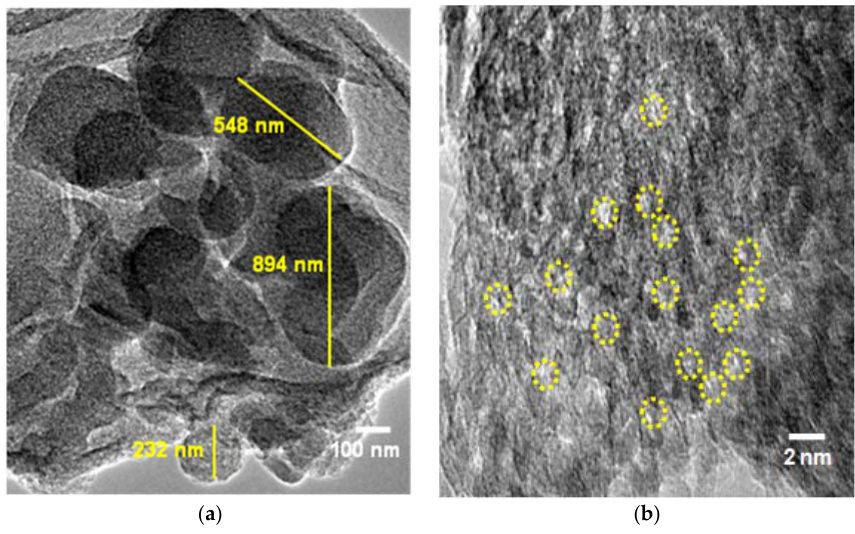
Figure 6. Transmission electron microscopy (TEM) micrograph of ( a ) SG ‐ HRS; and ( b )